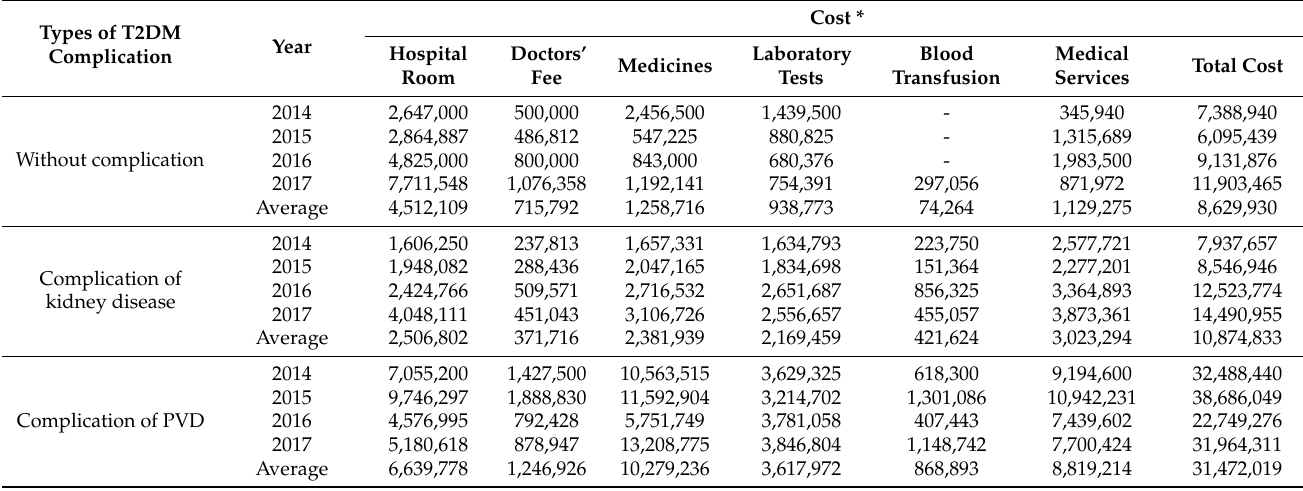
Table 2. Direct medical costs of T2DM treatment in Indonesian Rupiah (IDR) (1 US$ = IDR 13,451). Types of T2DM Complication